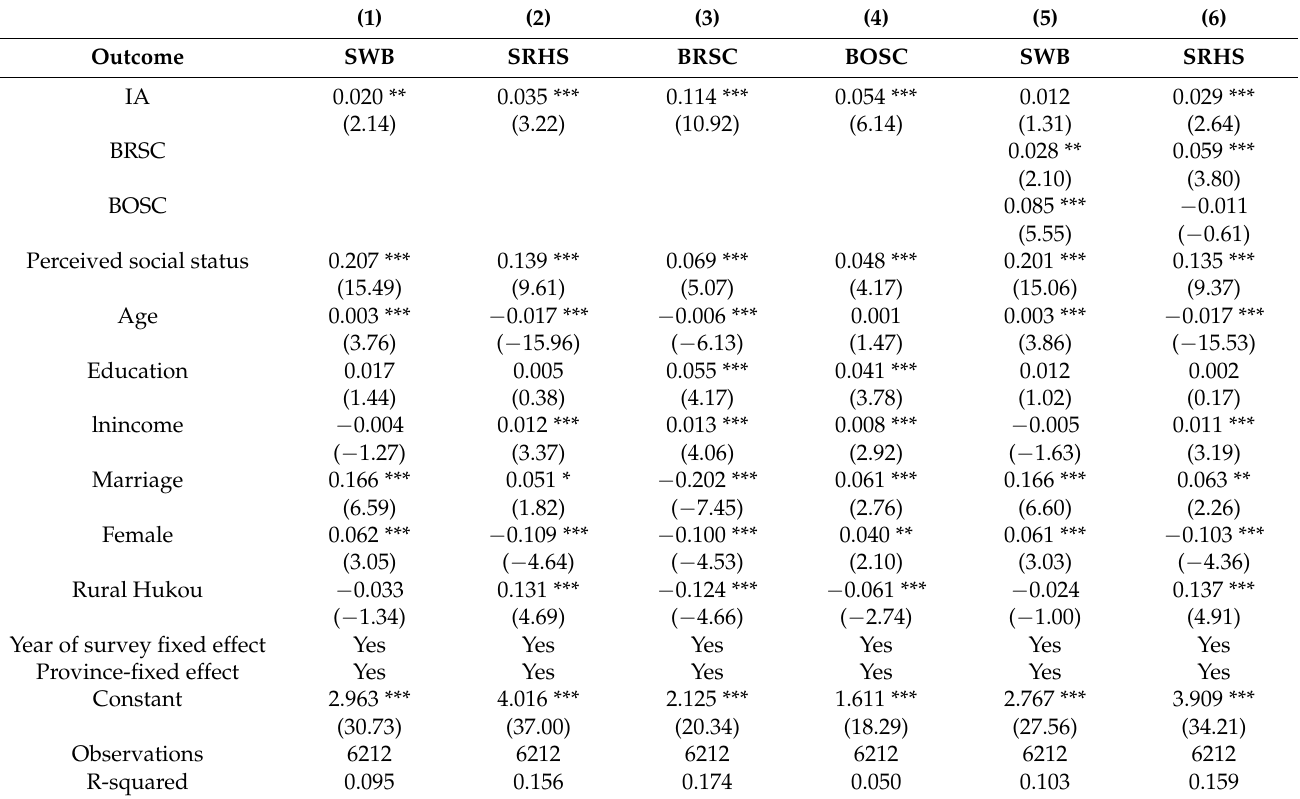
Table A1. The effect of IA on SWB and SRHS and the mediating role of two social